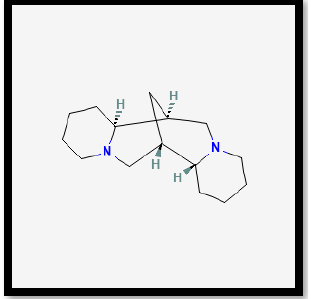
Figure 8. Chemical structures of papaverine.